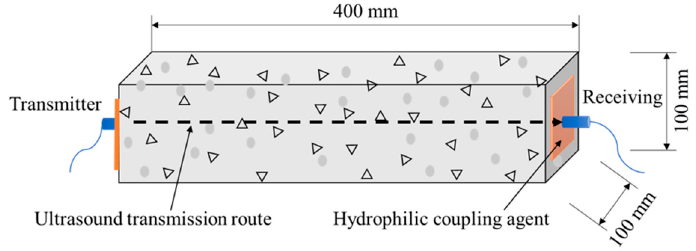
Figure 3. Ultrasonic direct-penetration method.